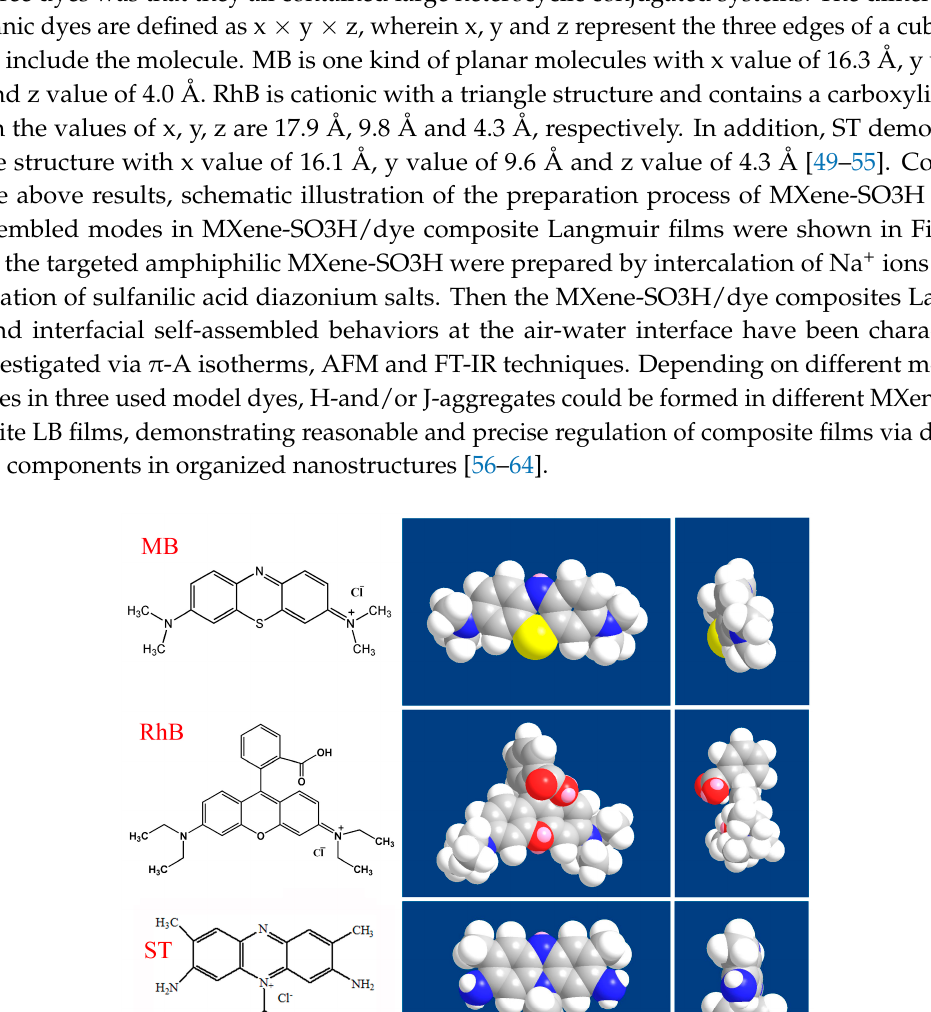
Figure 9. Chemical structures of three used model dyes along with the top and side views of their space-filling models.